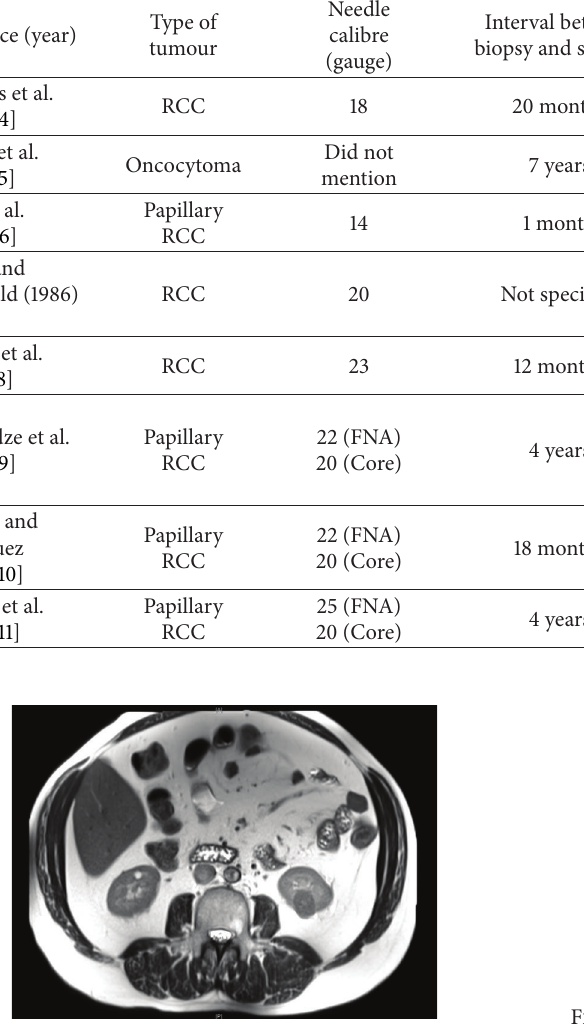
Figure 1: Magnetic resonance imaging (MRI) showing a 26 × 21mm left renal lower pole mass with a low T2 signal.